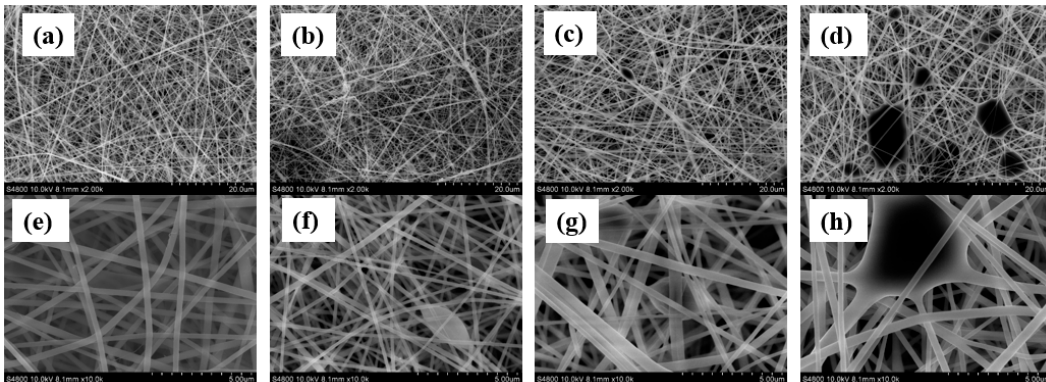
Figure 2. SEM images of SF nanofibers prepared by different electrospinning flow rates, at ( a ) 0.5 mL/h, ( b ) 0.6 mL/h, ( c ) 0.7 mL/h, ( d ) 0.8 mL/h, ( e ) 0.5 mL/h, ( f ) 0.6 mL/h, ( g ) 0.7 mL/h, ( h ) 0.8 mL/h. Note: Scale bars for ( a – d ) are 20 µm. Scale bars for ( e – h ) are 5 µm. Electric field: 1.83 kV/cm. Needle gauge: 20. SF concentration: 10 wt.%.